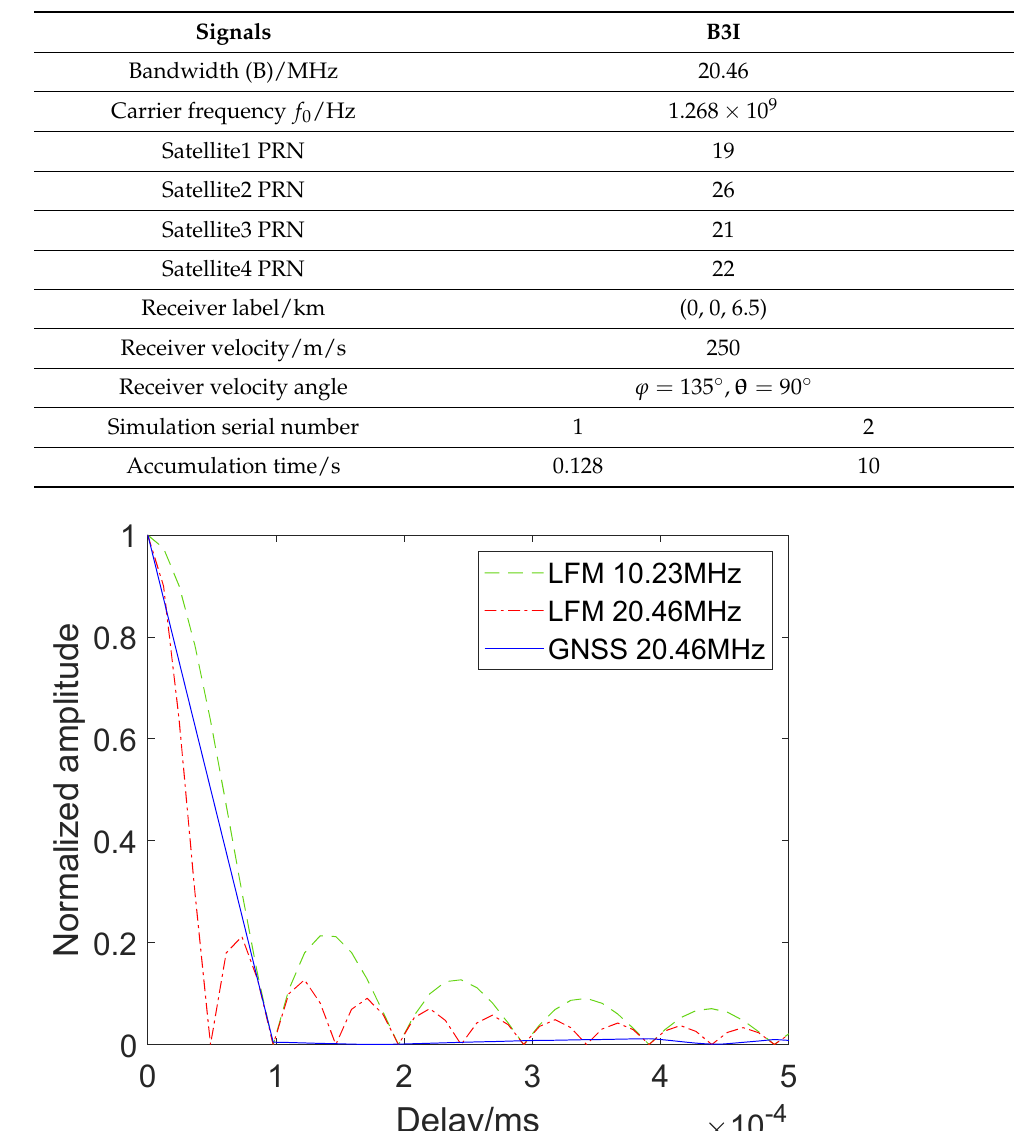
Table 1. System parameter.